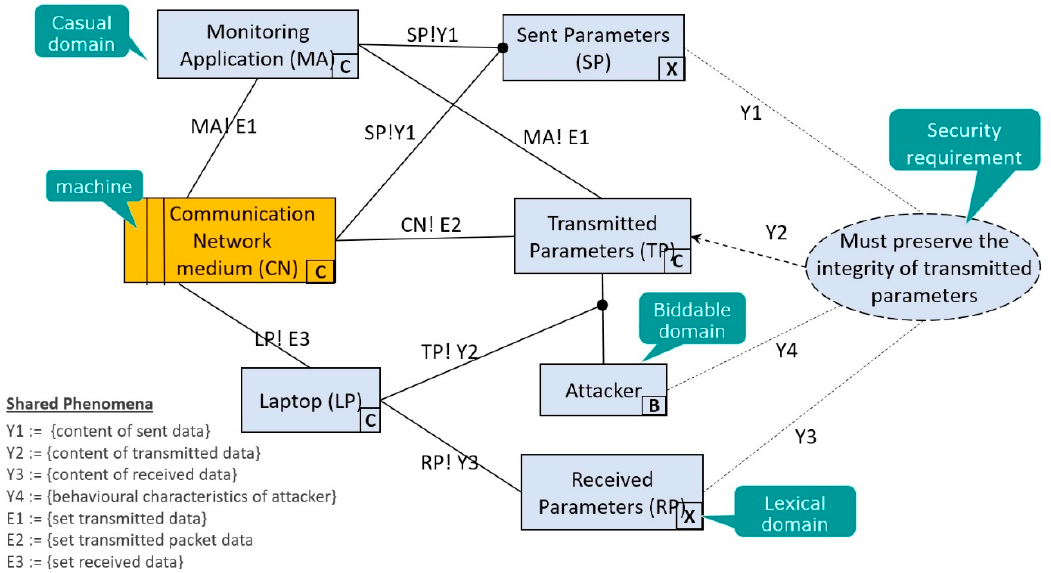
Figure 8. SEPP SPF diagram (sample).